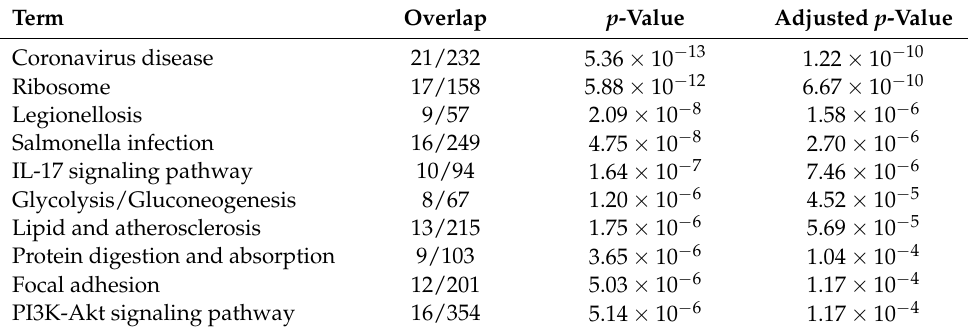
Table 4. The top 10 enriched terms in “KEGG 2021 Human” using Enrichr. Overlap is the number of common genes between the genes uploaded and the genes in the category divided by the number of genes in the category. Probes, whose associated genes were uploaded to Enrichr, were identified using PCA-based unsupervised FE.